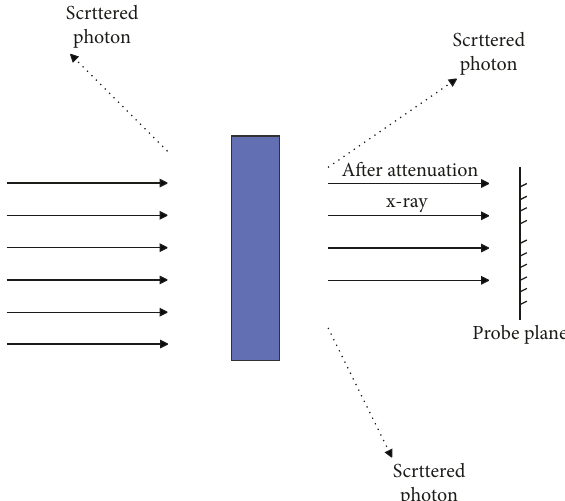
Figure 1: Schematic diagram of the material that transmits light to the robot vision.